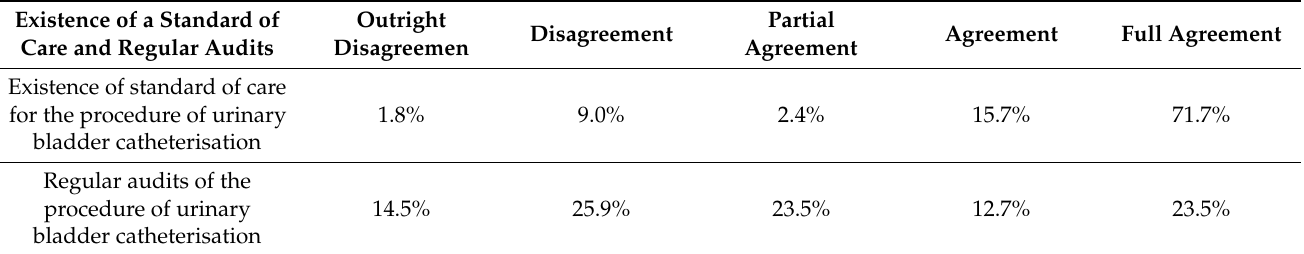
Table 5. Responses to items related to “existence of a standard of care and regular